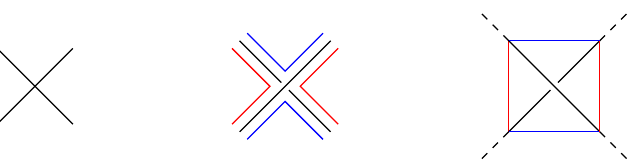
Figure 7 . The vertex of the CTKT model (4.2) in three di(cid:11)erent representation; from left to right: the Feynman representation, the stranded representation, and the \tetrahedron", or edge-colored representation. In the last two the colors track the